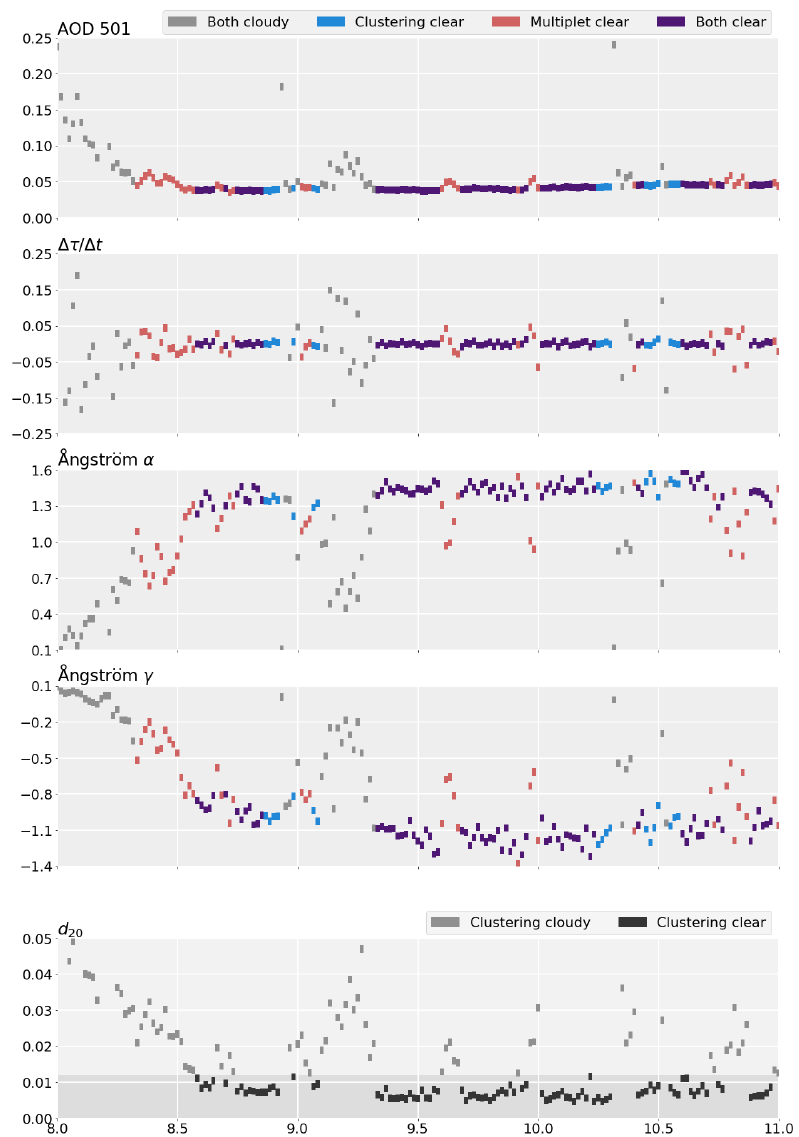
Figure 3. Three hours of an example day (12 March 2020) to illustrate the Clustering method: time series of the four dimensions used, as well as the time series of the distance measure d 20 . Colour of the rectangles codes for the flagging of the data point (see legend). For the distance measure d 20 , points below the threshold, i.e. categorized as clear by Clustering, are coloured dark grey, and cloudy points are in light